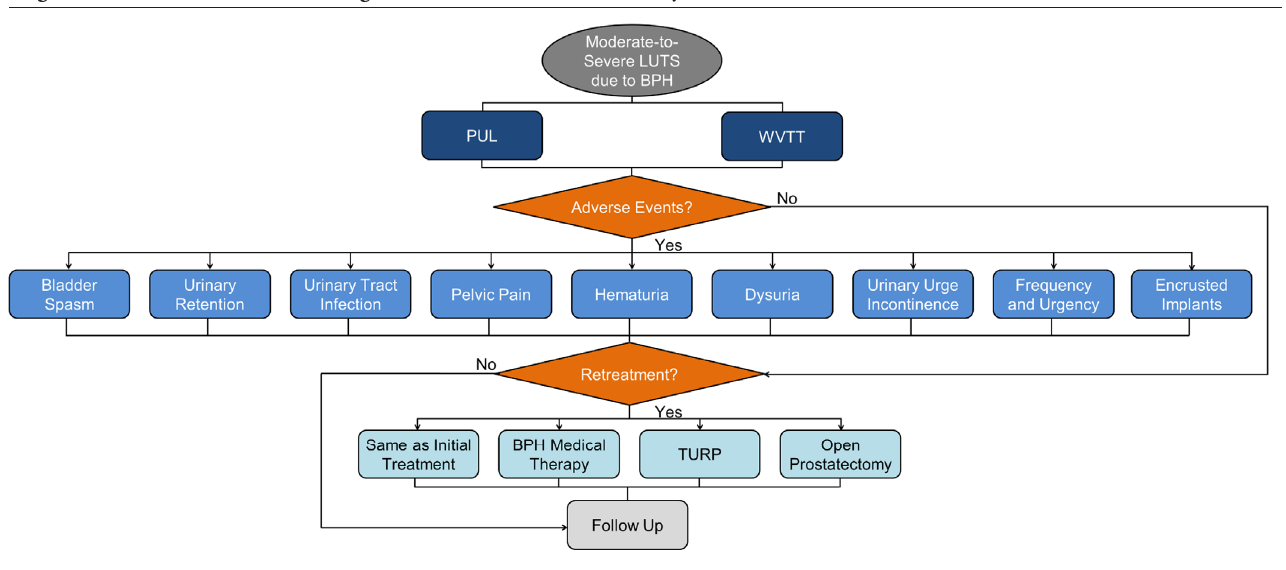
Figure 1. Model Schematic Describing PUL and WVTT Patient Pathway